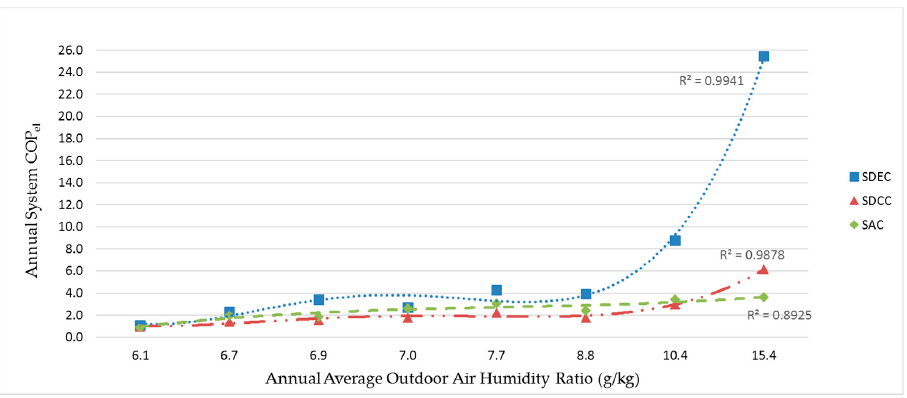
Figure 16. Correlation between outdoor air humidity ratio and annual system COP .